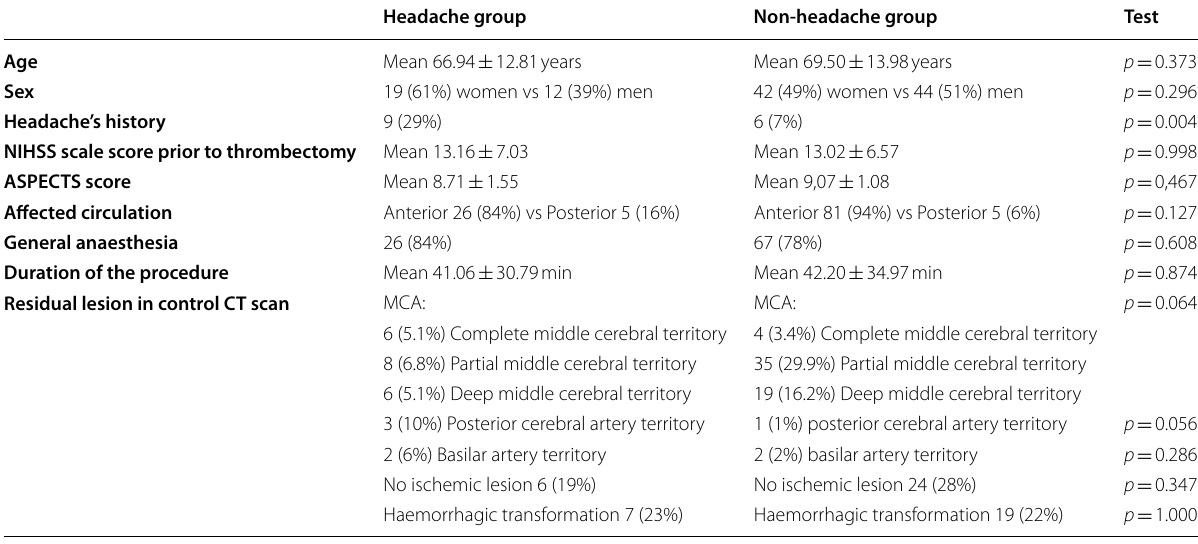
Table 1 Comparison of patients with headache vs patients without